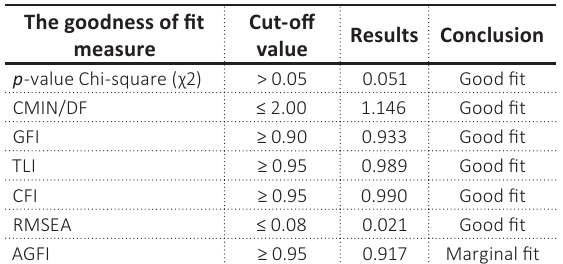
Table 1. Evaluation of goodness of fit indications criteria